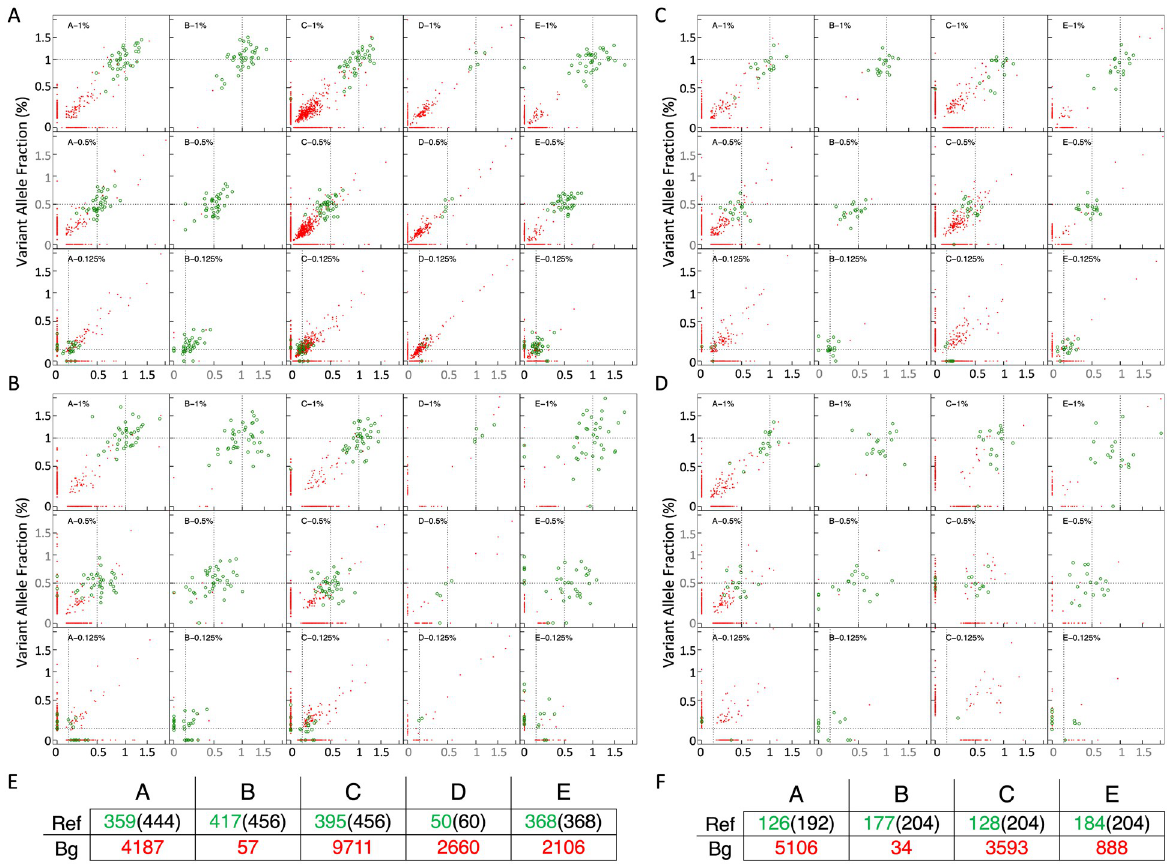
Fig 5. Reference mutations versus background noise across replicates. Every scatter plot displays a pair of replicates based on assay, VAF (0.125%, 0.5% and 1%) and input amount. Observed and expected VAF is represented in y and x axis; reference variants are colored in green and background noise in red. A, Background noise and VAF of reference mutations of solid tumor with 30 ng (assay A and B) or 50 ng (assay C, D, E). B, Same analysis for mutations of solid tumor with 10 ng input. C, Myeloid mutations with 30 ng (assay A and B) or 50 ng (assay C, D, E). D, Myeloid mutations with 10 ng. Through panel A to D, a high amount of background noise (red) was detected and overlapped with the lowest VAF level of the reference mutations evaluated (green) at 0.125% VAF for four of the five assays. Assay B showed exceptionally low background noise in all the samples. E, Summary table with number of detected reference mutations and background noise per assay for the solid tumor mutations (sum of 16 samples of sample set one); the total number of reference mutations covered by each assay was in parenthesis; ref, reference mutation; Bg, background noise. F, Similar summary table for the myeloid mutations (sum of 16 samples of sample set two).